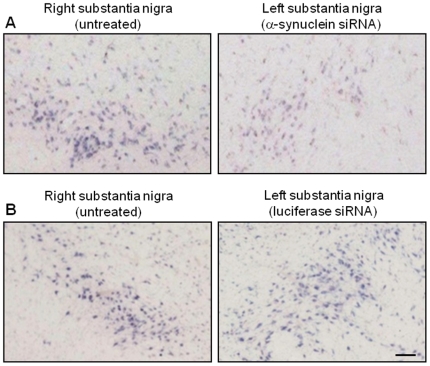
Reduction of α-synuclein mRNA in the substantia nigra infused with α-synuclein siRNA.Squirrel monkeys received a unilateral nigral infusion of siRNA targeting α-synuclein (A) or luciferase (B). Midbrain sections at the level of the exit of the 3rd nerve were used for α-synuclein in situ hybridization using digoxigenin-labeled antisense riboprobes. Representative images compare α-synuclein mRNA in the right (untreated) vs. left (siRNA-infused) substantia nigra. Scale bar = 100 µm.